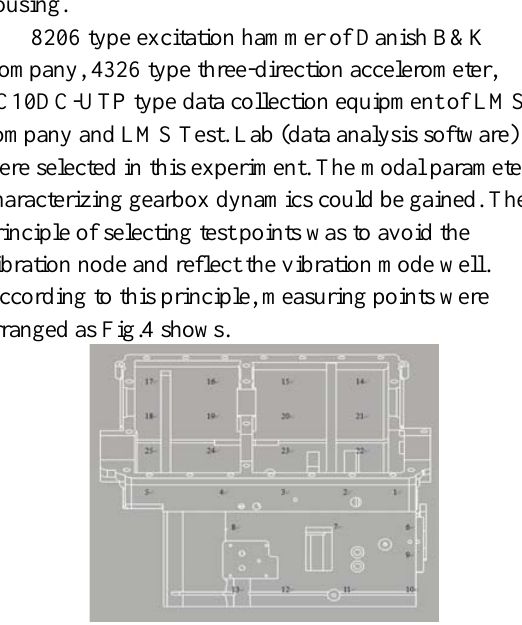
Fig.4. The arrangment of test points in down housing